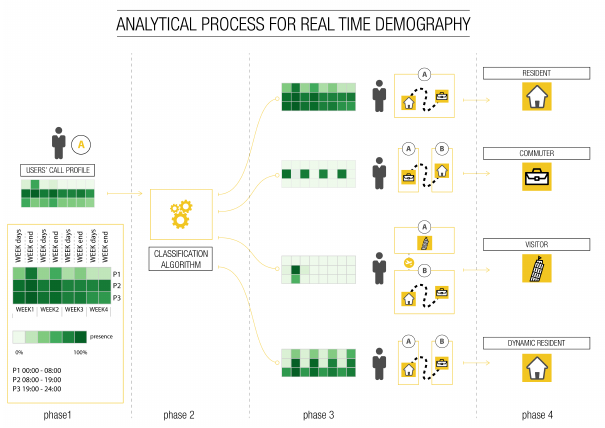
Figure 1. Sociometer: Starting from raw call data record,